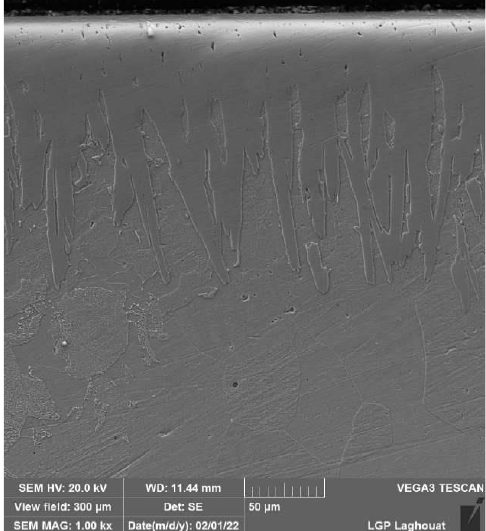
Fig. 2. Micrograph of boride layer on X52 steel.